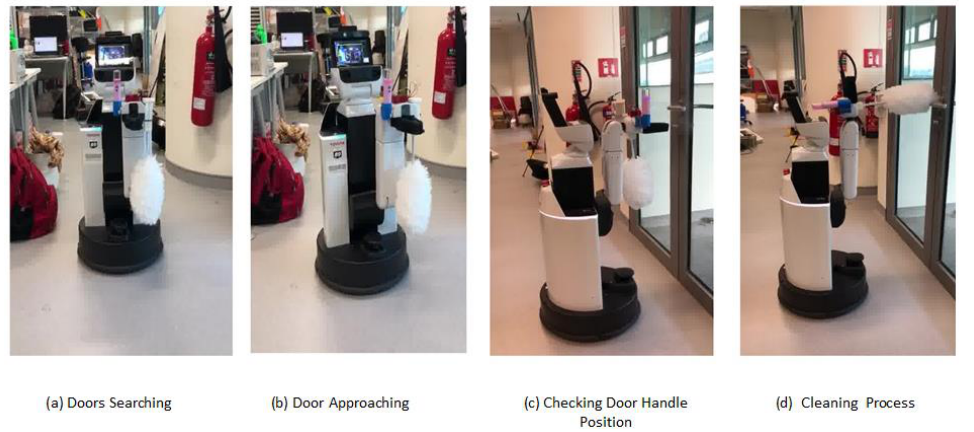
Figure 8. Real-time door-handle cleaning demonstration.